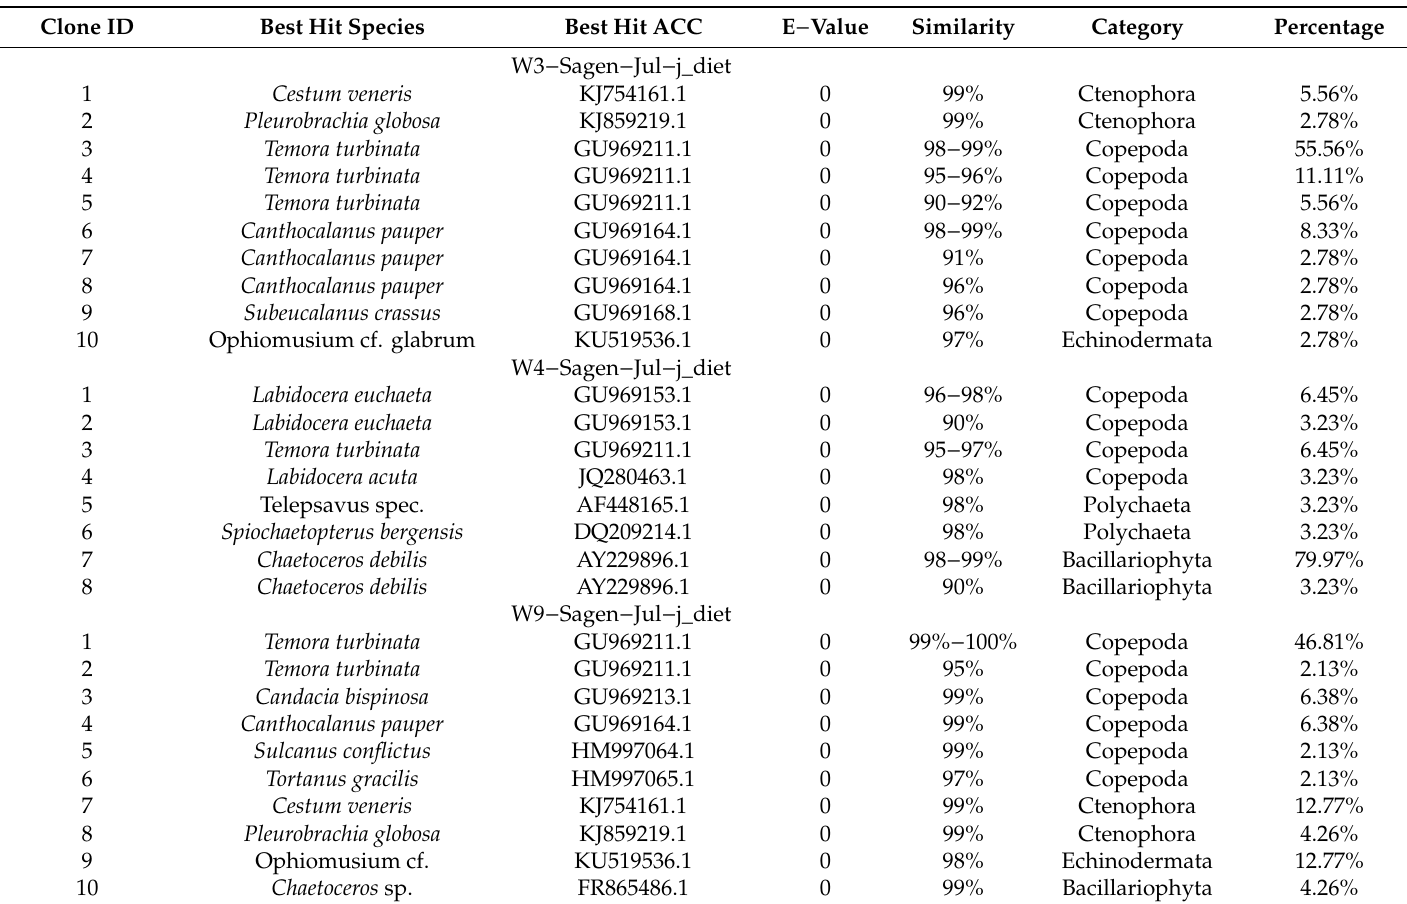
Table A2. Taxonomic classification and distribution of 18S rDNA clones retrieved from F. enflata juveniles sampled in summer and autumn in Sanya